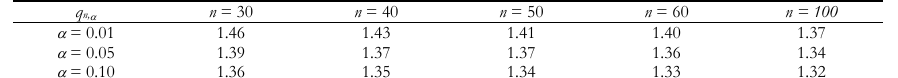
Critical values q n, α of the UMP scale invariant test